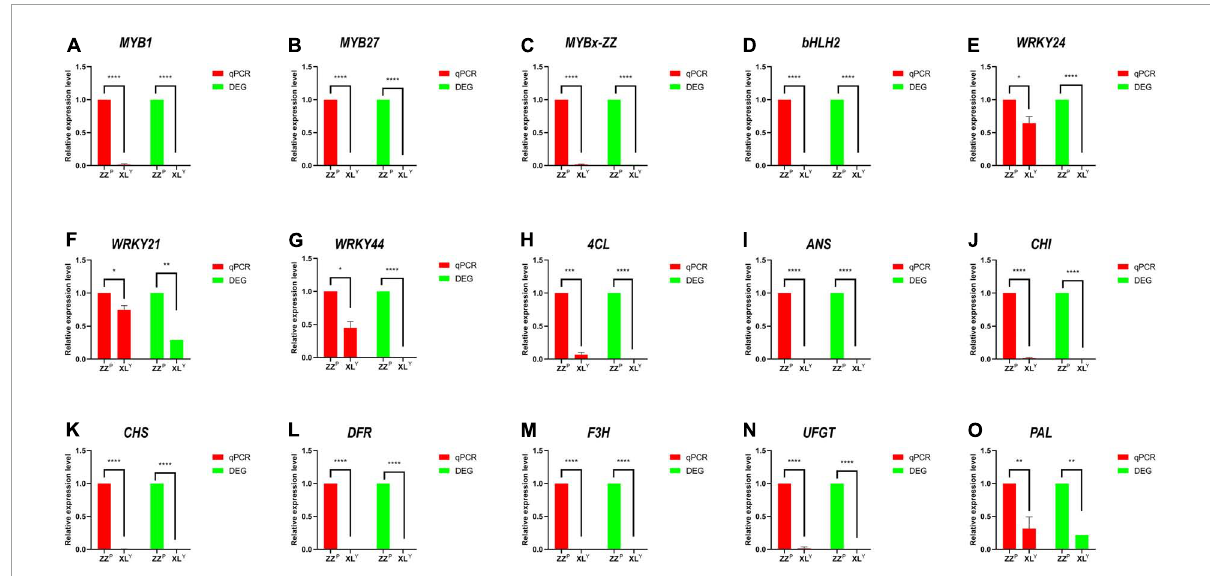
FIGURE3 Verification of the relative expression level of DEGs in the tuberous roots of sweet potato by qRT-PCR. Expression levels were standardized to GADPH , and results in the ZZ P were set to 1. Expression patterns of 15 DEGs related to anthocyanin biosynthesis pathway including (A–G) TFs and (H–O) structural genes. The red bar shows relative gene expression level measured by qRT-PCR, and the green bar shows the FPKM of relative gene in RNA-seq. Error bars indicate the standard deviation from three biological replicates. Asterisks represent statistically significant differences (**** P < 0.0001, *** P < 0.001, ** P < 0.01, * P < 0.05), as analyzed using Student’s t